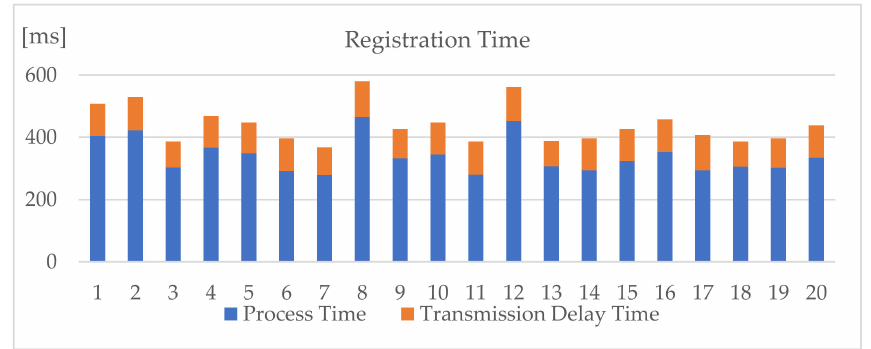
Figure 18. RTTs of IoT device